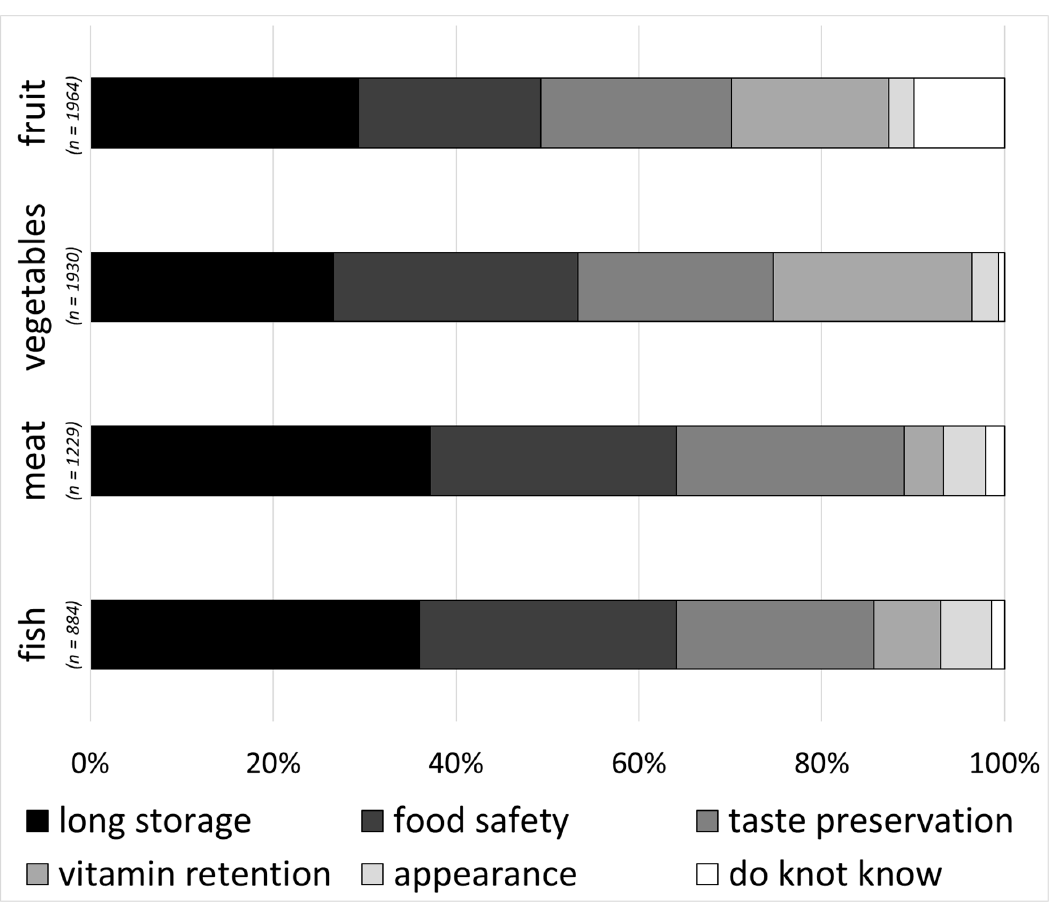
Figure 5. Consumer storage performance requirements for fruit, vegetables, meat and fish (multiple-choice, multiple-answers).